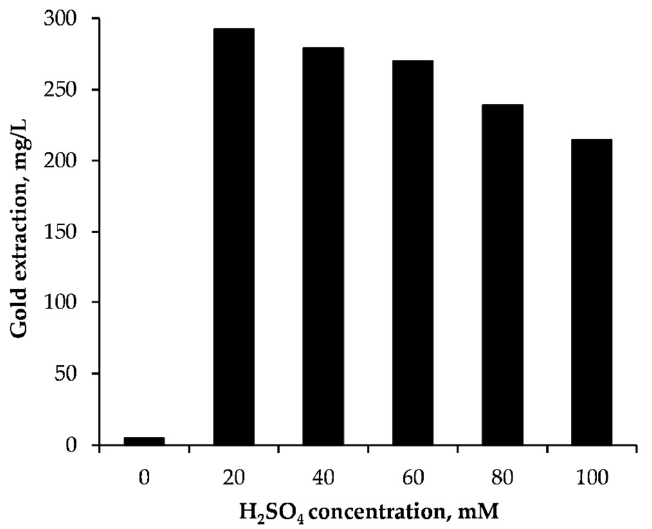
Figure 4. Gold extraction as a function of H 2 SO 4 concentration in the KI–H 2 O 2 –H 2 SO 4 solution.